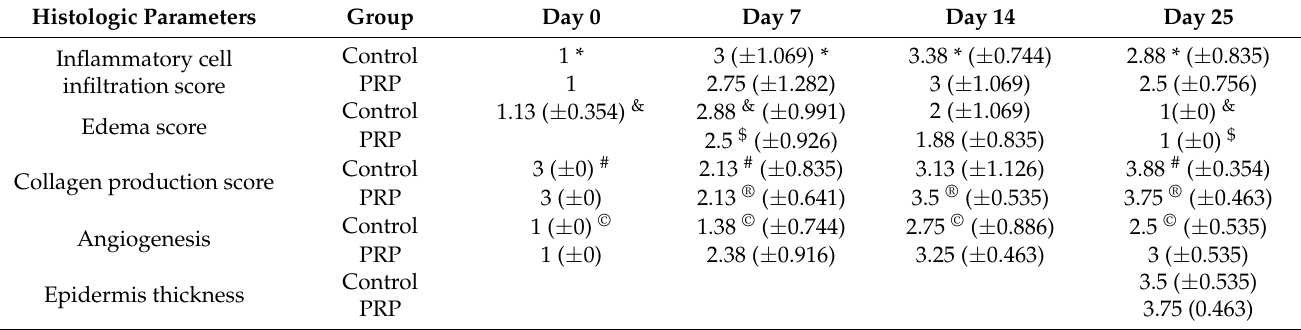
Table 5. Histologic measurements in PRP and control group on days 0, 7, 14, and 25 in the eight